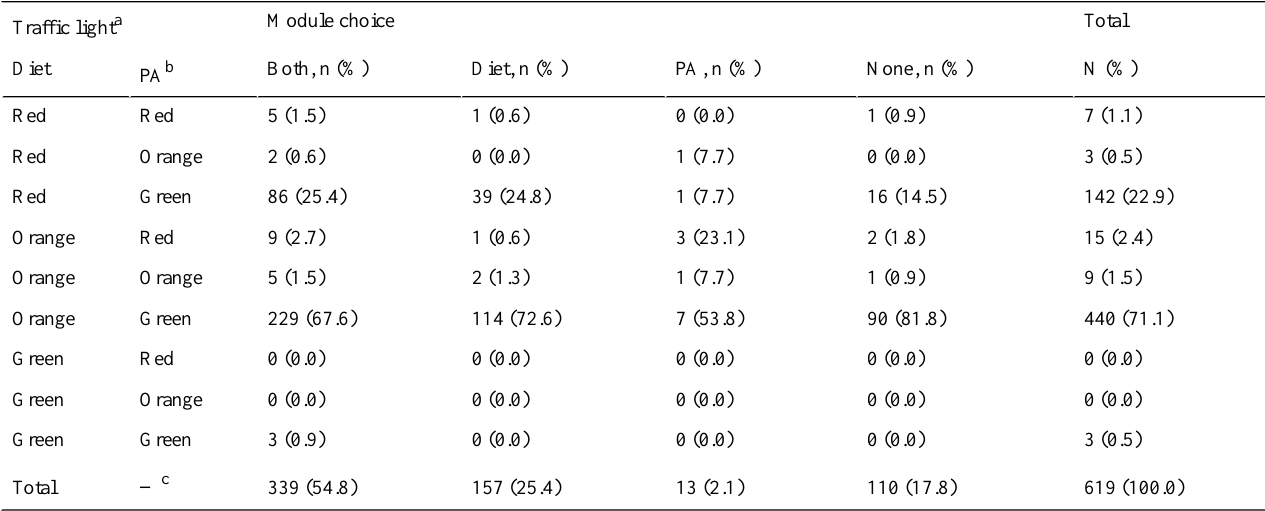
Table 2. Overview of advice and module choice.